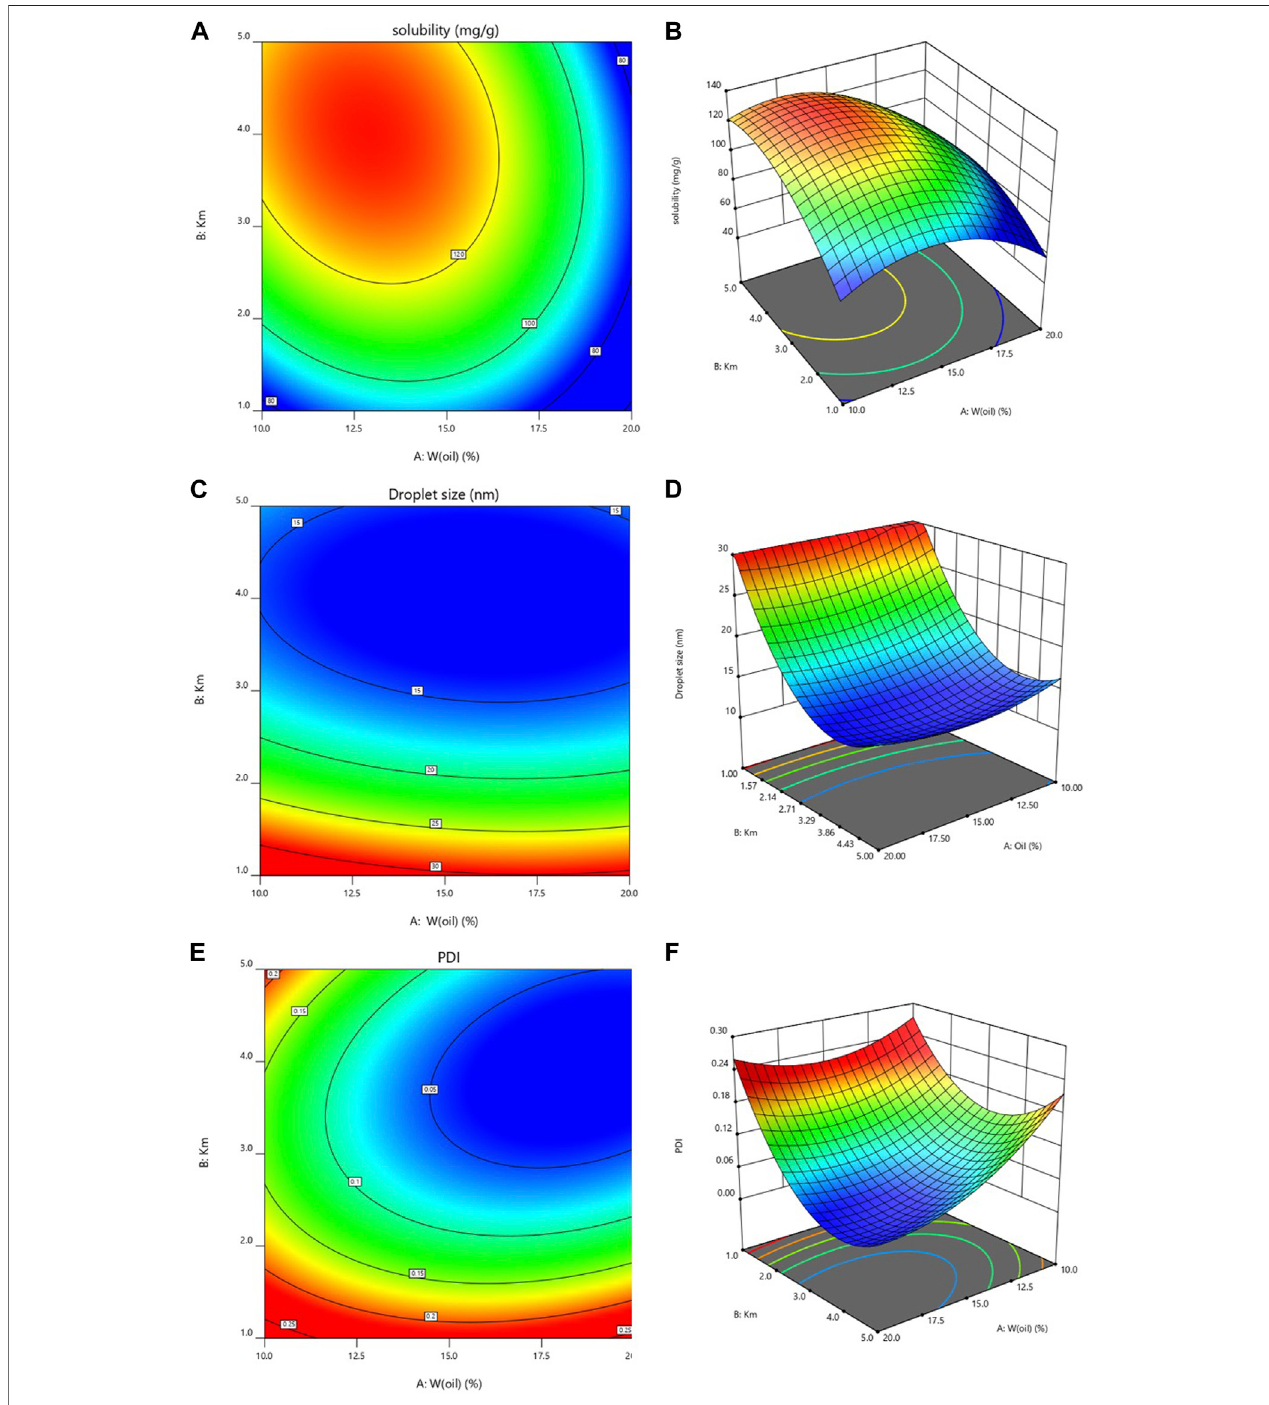
FIGURE 4 | Three-dimensional (3D) response surface (A) : dissolvability; (C) : Droplet size; (E) : PDI) and contour plot (B) : dissolvability; (D) : Droplet size; (F) : PDI.